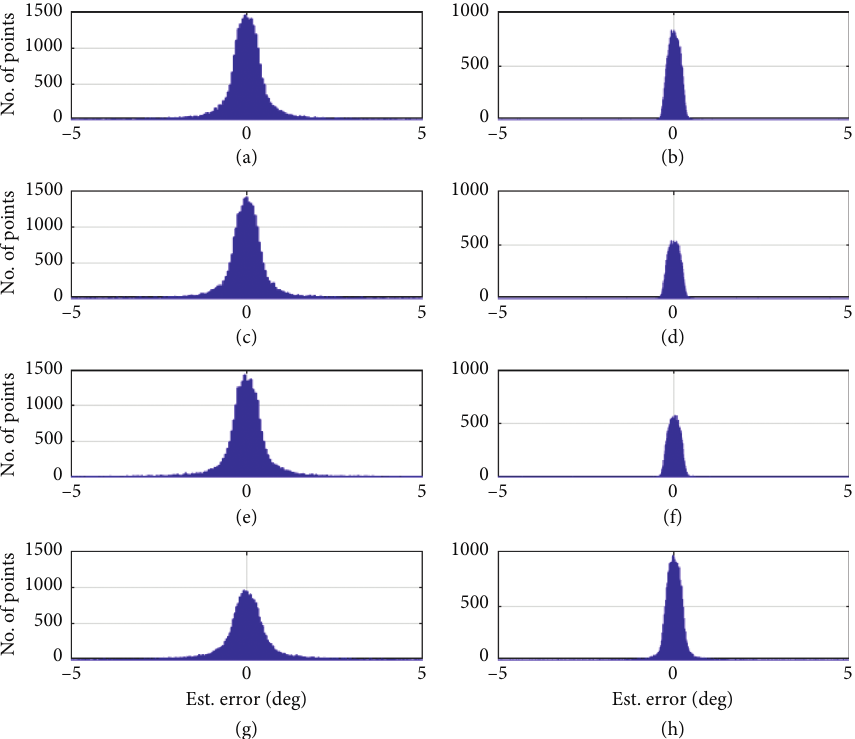
Figure 10: The histograms of Az (left column) and El (right column) estimation errors, when 10dB ≤ SNR ≤ 20dB with 1025 snapshots. (a, b) WF-1; (c, d) WF-2; (e, f) WF-3; (g, h) WF-4.